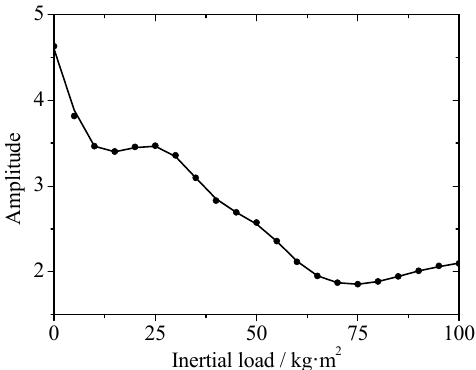
Figure 15. Radial vibration amplitude of planet carrier under different inertial loads.